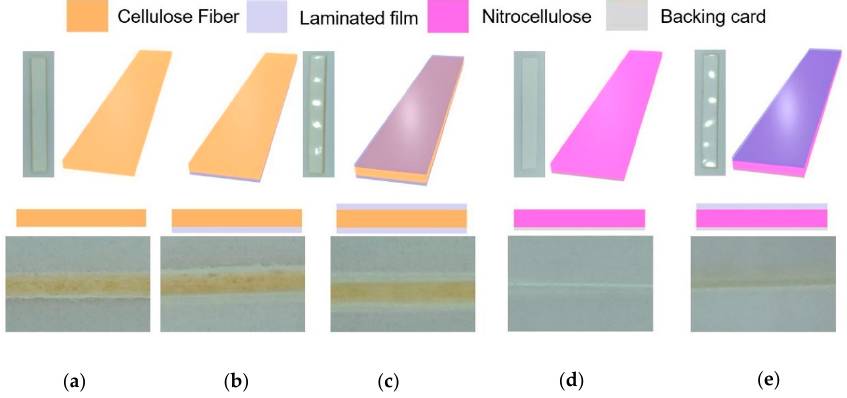
Figure 3. Paper types used in the experiment: ( a ) non-laminated CFSP, ( b ) one-side laminated CFSP, ( c ) both-side laminated CFSP, ( d ) nitrocellulose (NC) membrane, ( e ) laminated nitrocellulose membrane.